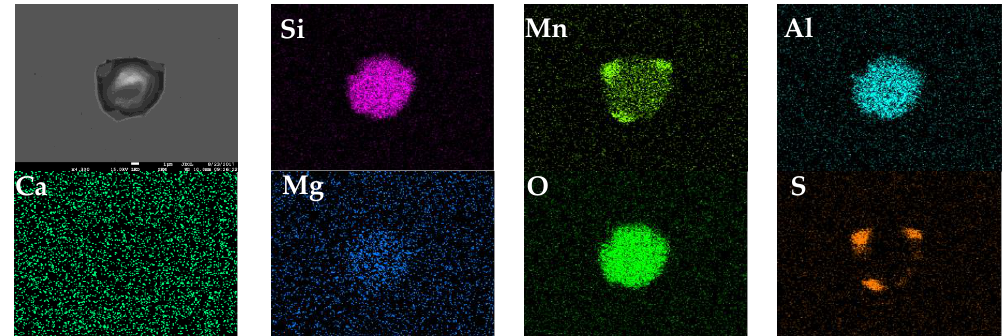
Figure 13. SEM mapping of typical inclusions in normal experiment heat.